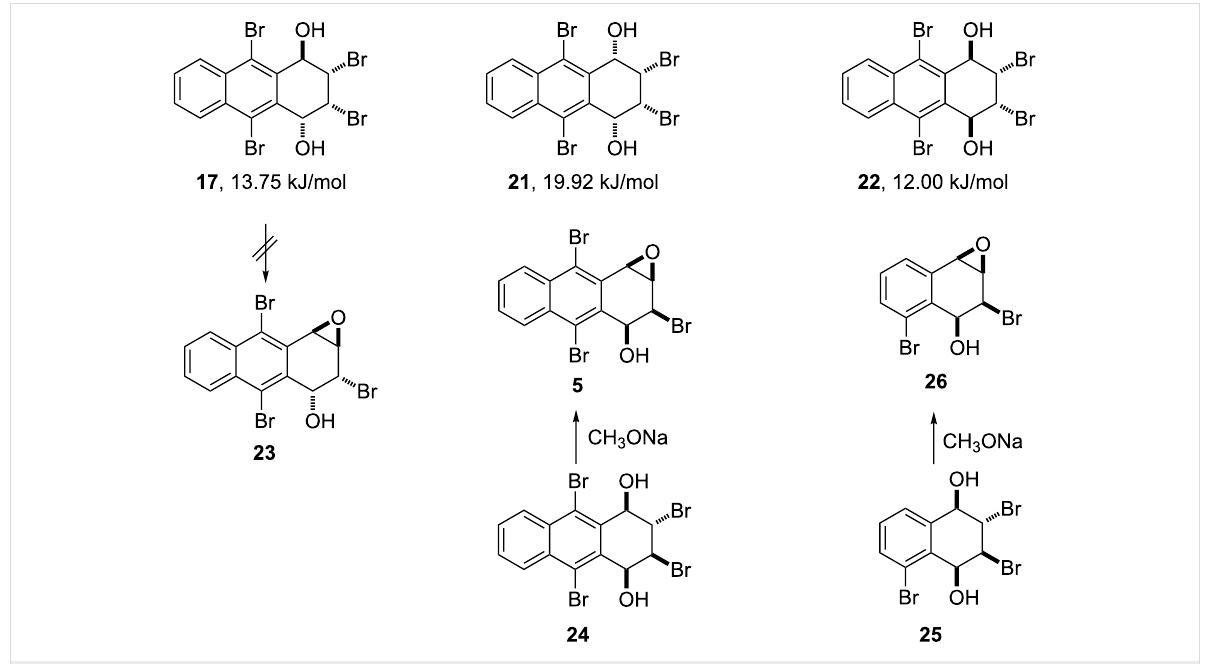
Scheme 5: Base-promoted reaction of the dihydroxides and formation of the epoxides.